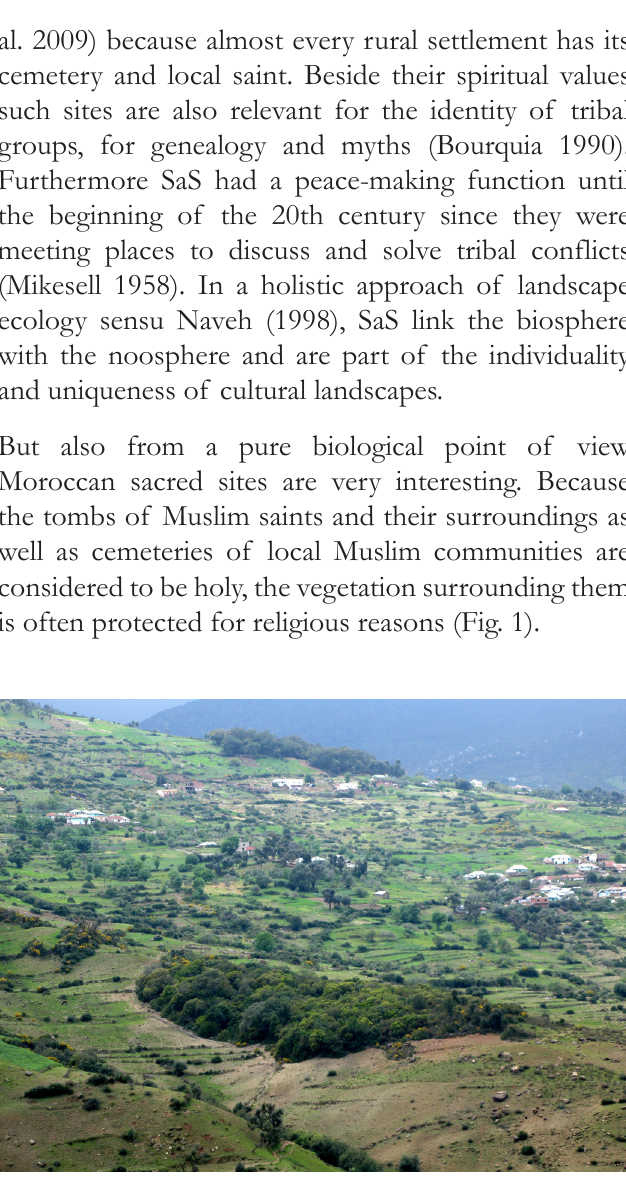
Figure 1: Two isolated sacred groves with closed tree canopy on small ridges in mid-slope position within short to medium distance to scattered settlements (Area of the Beni Ider tribe, landscape section D1, NW